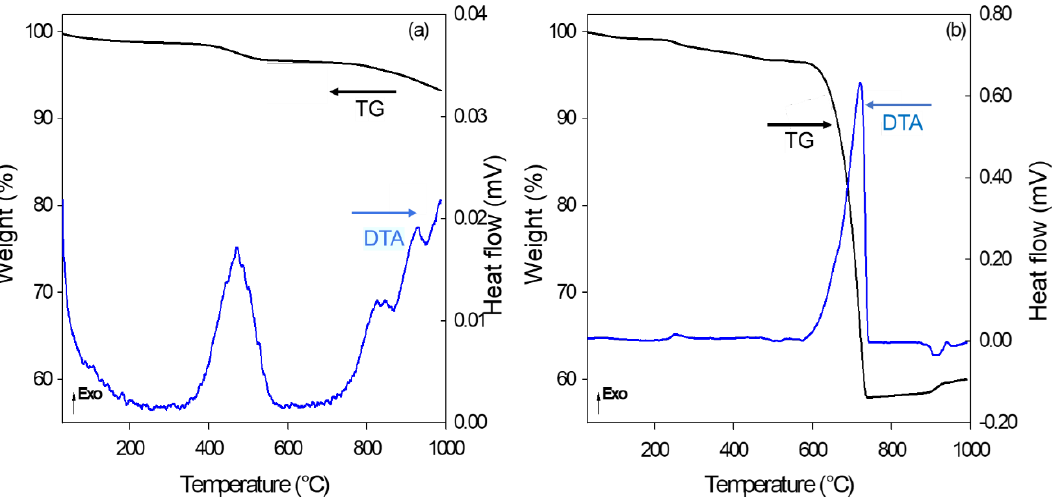
Figure 1. Differential thermal (DTA) and thermogravimetric (TGA) analyses of RHA ( a ) and CaCO 3 ( b